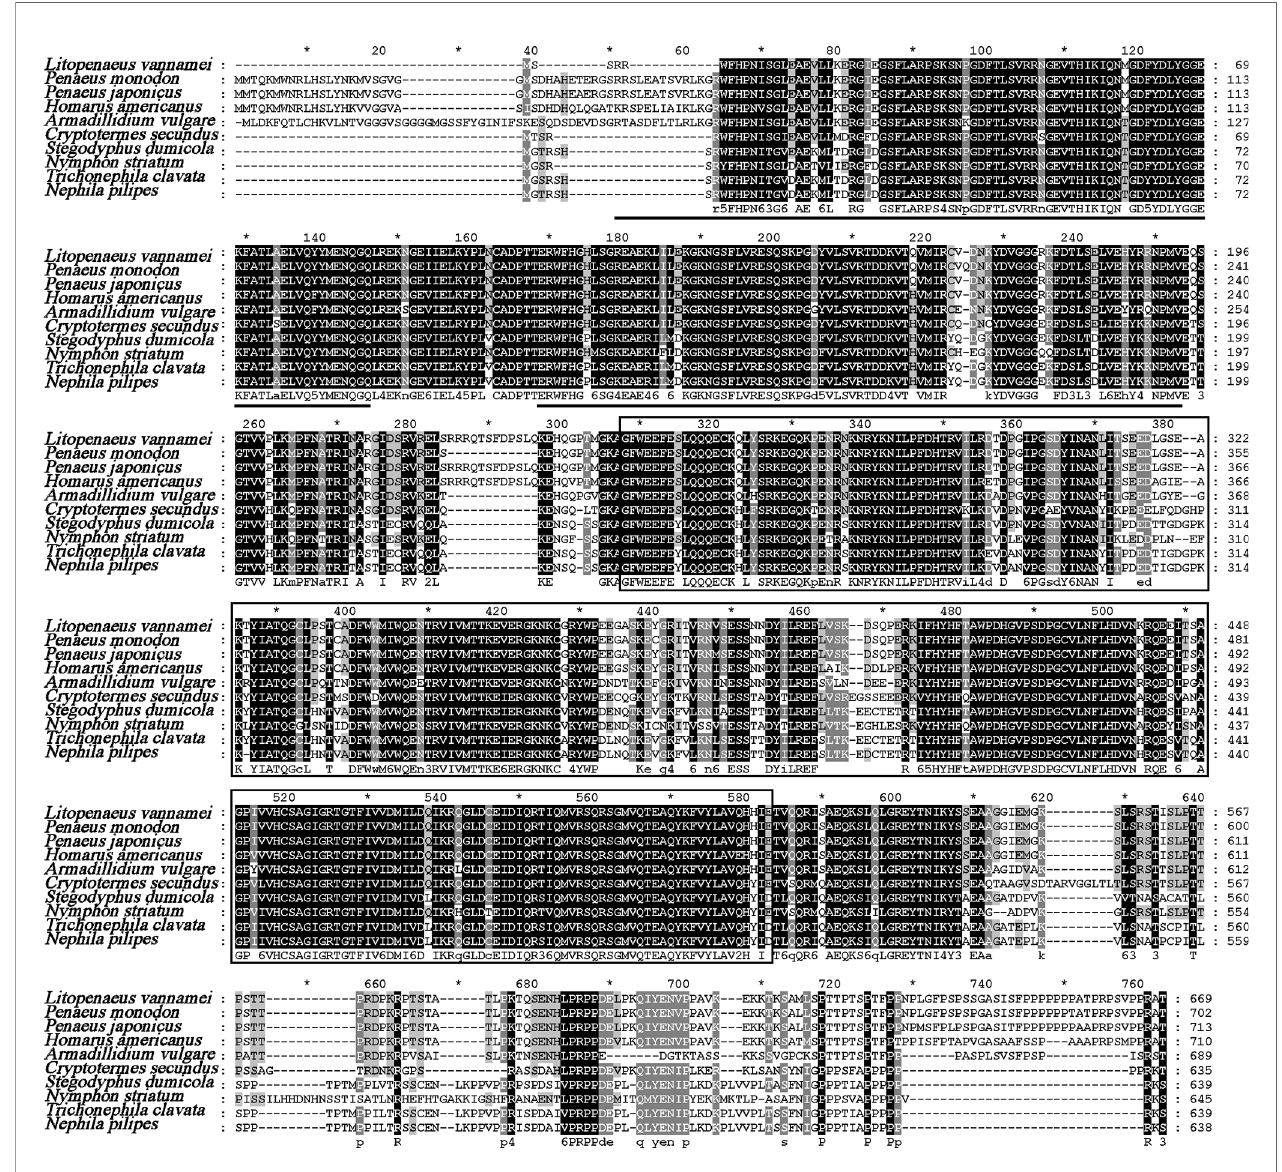
FIGURE 1 | Multiple-sequence alignment of PTPN6 homologs. The two predicted SH2 domains were underlined, and the PTPc domain was framed. The amino acid sequence of PTPN6s was obtained from NCBI with GenBank accession numbers of Penaeus monodon (XP_037785856.1), Penaeus japonicas (XP_042879519.1), Homarus americanus (XP_042242946.1), Armadillidium vulgare (RXG72814.1), Cryptotermes secundus (XP_023713602.1), Stegodyphus dumicola (XP_035233634.1), Nymphon striatum (KAG1683061.1), Trichonephila clavata (GFR09275.1), and Nephila pilipes (GFS80663.1). The fi ve tines star "*" means the middle position of the two Numbers beside